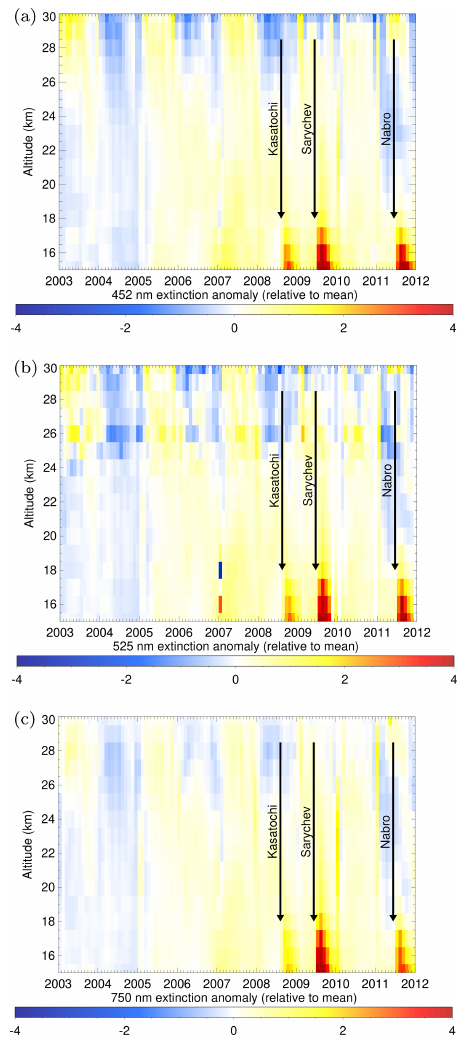
Figure 14. Time series of relative aerosol extinction anomalies from SCIAMACHY solar occultation at (from top to bottom) 452, 525 and 750nm. The start times of some major volcanic eruptions occurring at higher latitudes are marked.